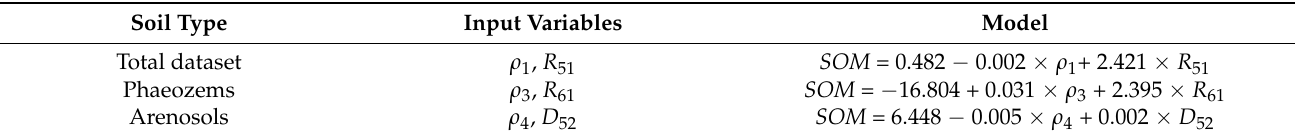
Table 8. Optimal models for the total dataset, Phaeozem, and Arenosol.